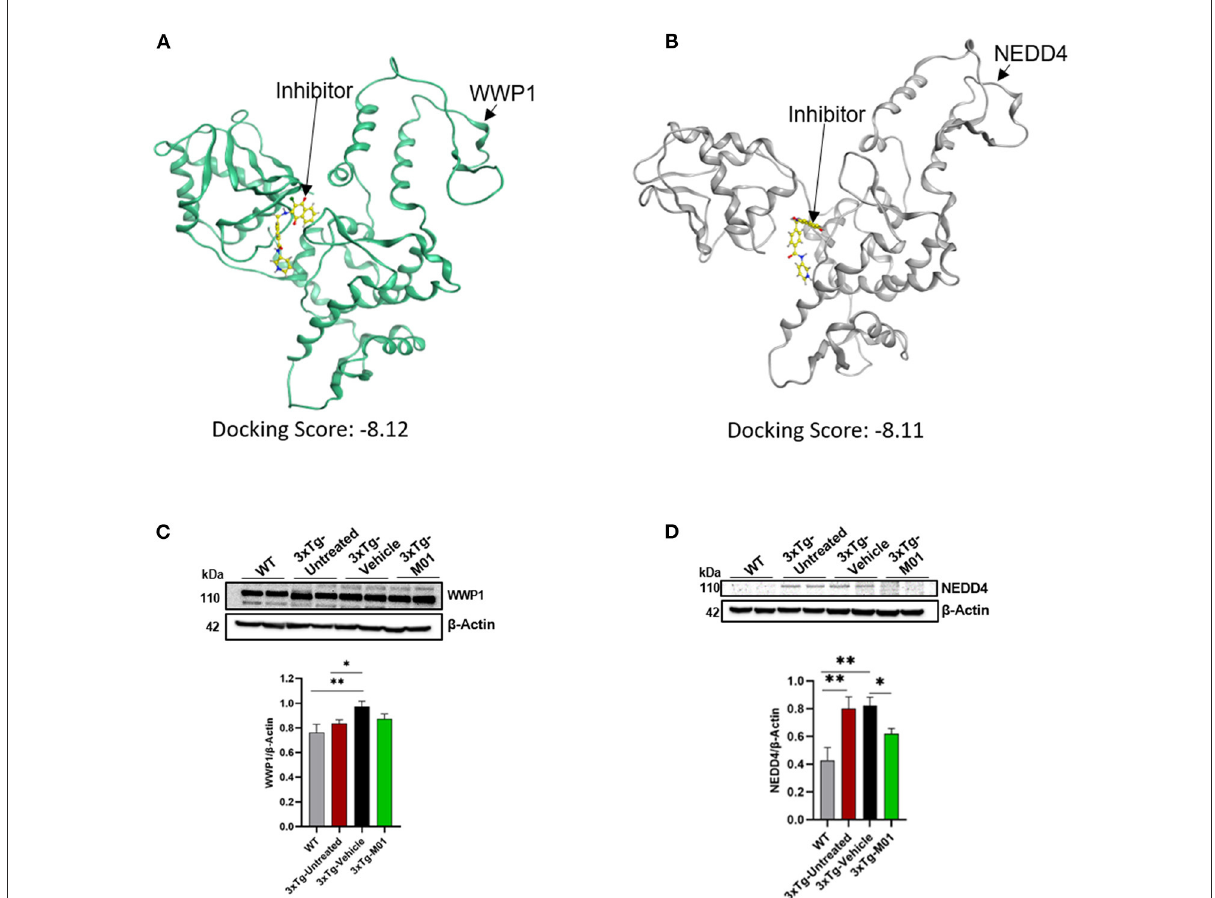
FIGURE7 M01 has a high binding affinity with WWP1 and NEDD4 E3 ligase. Protein structure of (A) WWP1 (green) (PDB code: 1ND7), (B) NEDD4 (gray) (PDS code: 5C91) docked with M01 (yellow), (C) Images of western blotting of anti-WWP1, and (D) anti-NEDD4 antibodies against protein extraction from the hippocampus. M01 treatment significantly decreased the protein level of NEDD4 E3 ligase in 3xTg mice. The results are plotted as mean ± SEM. * p < 0.05, ** p < 0.01. n = 5–6/ group for western blot